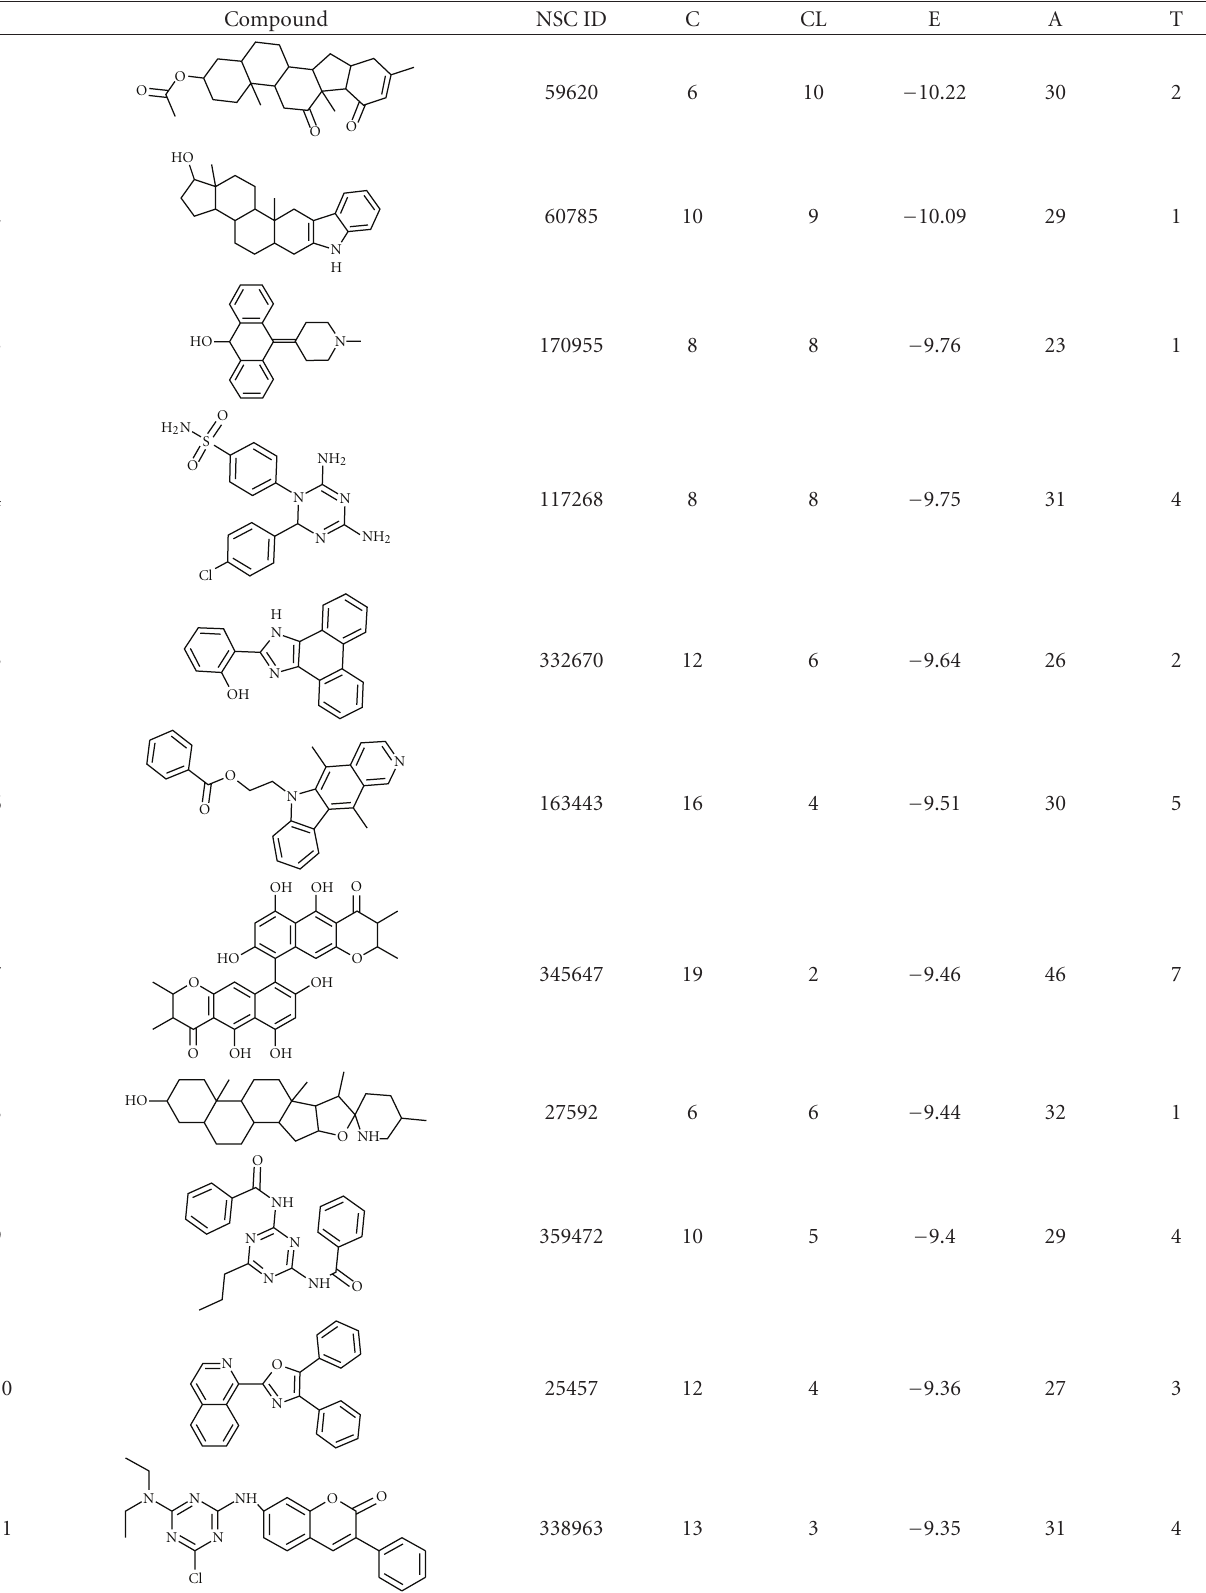
Table 1: Structure and docking statistics of top 50 ranked structures. C, CL, E, A, and T indicate numbers of clusters, number of conforma- tions within the selected cluster, binding energy of the selected conformation in kcal/mol, number of atoms in the inhibitor, and number of torsions,